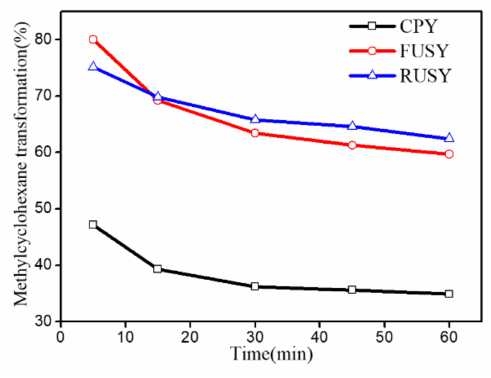
Figure 6. The product yield of three main types of products on the three Y-zeolite samples A: aromatics, I: isomerization products, C: cracking